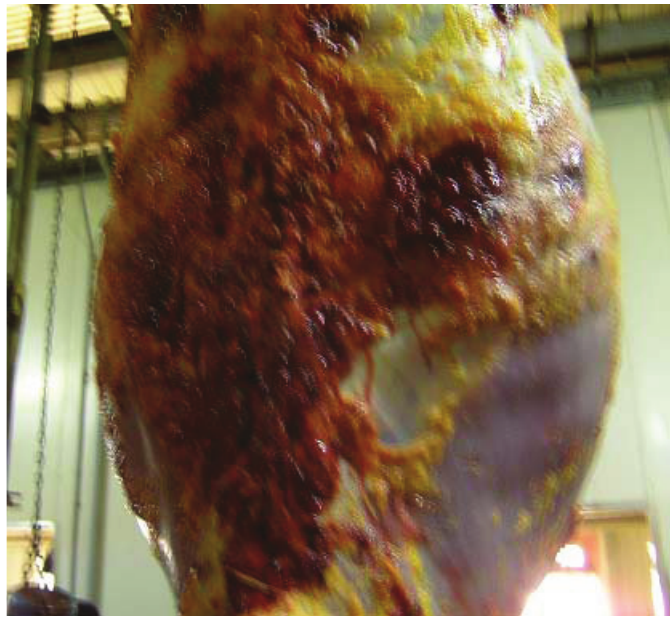
Figure 6. Meat bruise of a carcass at Kumasi